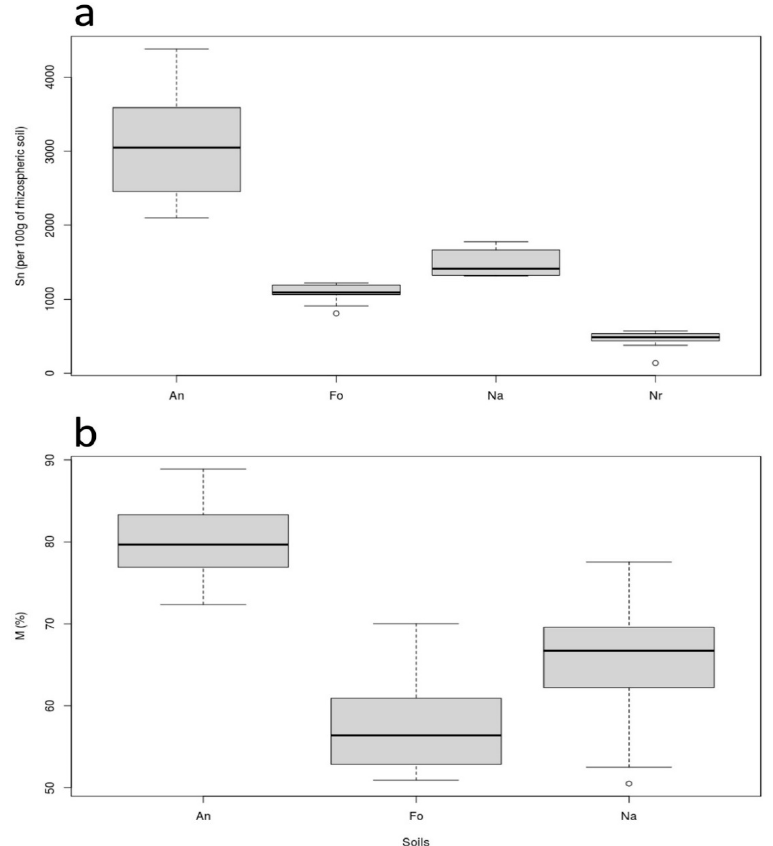
Figure 4. Variability of ( a ) spore number (Sn) and ( b ) mycorrhization intensity (M) between the studied soils. The box and whisker diagrams include median value (dark rectangle), range of 50% of the samples (large rectangle), maximum and minimum values (cross bars), and outliers (circle). Compared with the control, An had six times higher P levels, five times higher TKN levels, and twice higher TOC levels. It also showed 37% higher mycorrhization intensity than Fo and six times higher spore density than Nr. Compared with Na, An had twice higher P levels, 47% higher TKN levels, 35% higher TOC levels, 22% higher M, and twice higher spore density. Compared with Nr, Na had three times higher P levels, three times higher TKN levels, and 65% times higher TOC levels. It also showed 12% higher mycorrhization intensity than Fo and three times higher spore density than Nr. Na and Fo did not differ much, and all differences were insignificant. Lastly, Fo had twice higher P content than Nr, three times higher TKN content, 58% higher TOC content, and twice higher spore density than Nr. The studied variables’ correlations were grouped by soil type in Tables 2–5. For An, a strong and significant positive correlation was found between P and M, P and Sn, M and Sn, Sn and TKN, and Sn and TOC and a moderate positive correlation between P and TKN (Table 2). For Na, a strong and significant positive correlation was found between P and M and between M and TKN, a moderate positive correlation between P and TKN and between M and TOC) and a strong negative one between TKN and C/N (Table 3). For Fo, a strong and significant positive correlation was noted between P and M and between M and Sn and a strong negative one between TKN and C/N) (Table 4). Lastly, the Nr soil type had one strong significant negative correlation between TKN and C/N (Table 5).